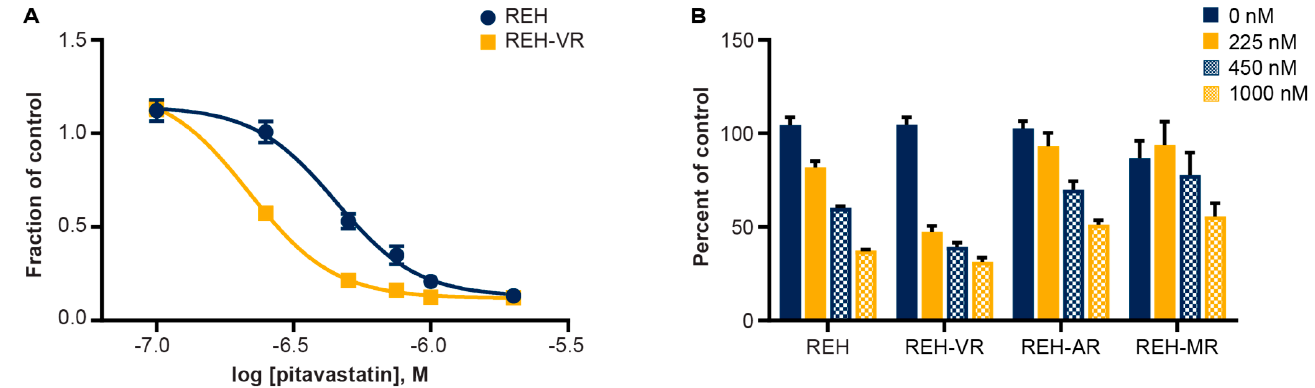
Figure 2. Pitavastatin reduces cell proliferation in leukemic cells. ( A ) REH and REH-VR were treated with pitavastatin for 48 h. ( B ) REH, REH-VR, REH-AR, and REH-MR cells were treated with pitavas- tatin for 48 h. The concentration of pitavastatin used was based on the IC 50 values obtained from the inhibition curves ( A ), as well as an additional 2X the IC 50 of REH. CCK-8 (WST-8) assay was used to determine cell proliferation. Data shown as fraction of control, or percent of control, when compared to vehicle control. The calculated IC 50 values for the REH and REH-VR cells were 449 nM and 217 nM, respectively. Each symbol is average ± S.D., where n = 3.